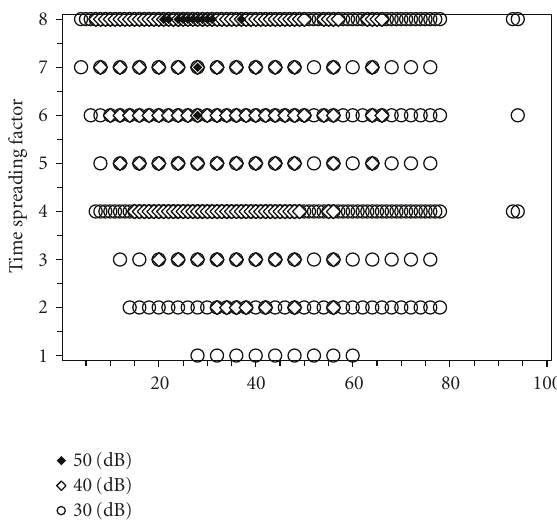
Figure 10: Time and frequency spreading configurations of SS- OFDM system which lead to at least 99.5% of the maximal value of the reliable rate upper-bound R , over PLC channel no. 1 and for three channel attenuations { 30,40,50 }